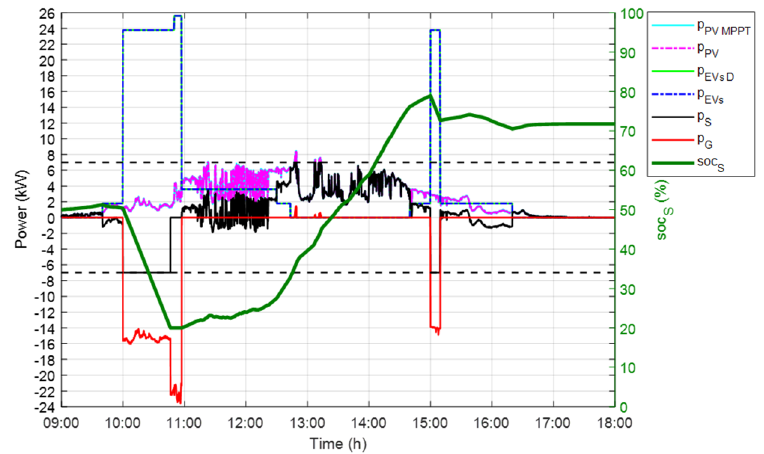
Figure 23. Scenario 2e, system power flows and stationary storage SOC evolution.